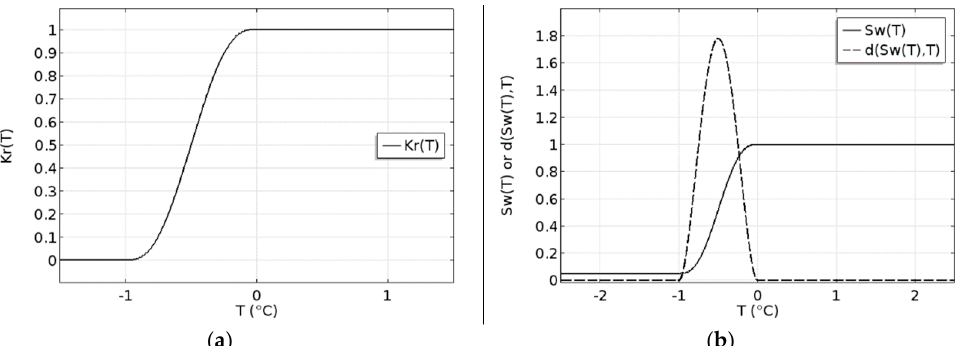
Figure 2. The temperature dependent parameters employed in the numerical implementation: ( a ) Effective hydraulic conductivity curve with various temperatures; and, ( b ) The function of water saturation and freezing with various temperatures.